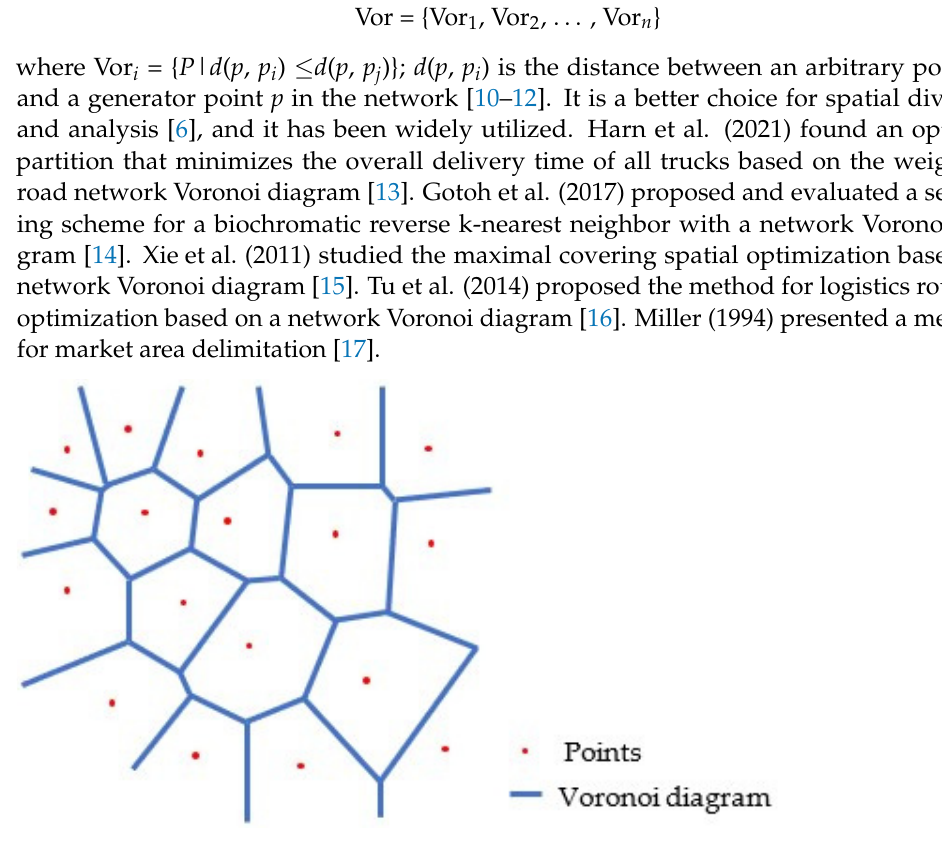
Figure 1. An example of the planar Voronoi diagram.